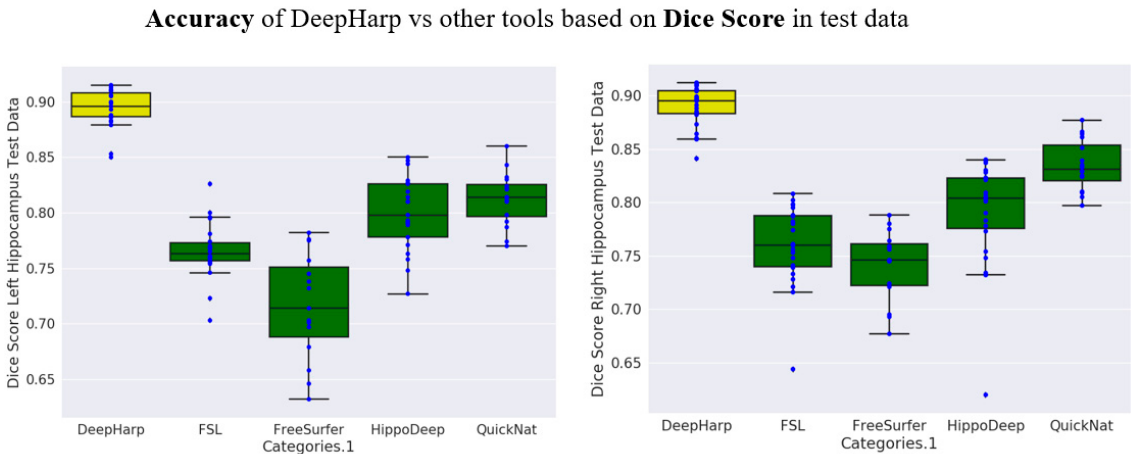
Table 2. Accuracy and precision of the DeepHarp method compared to other methods: the metric is the Dice coefficient. The bold numbers are showing highest Dice scores. DeepHarp has highest Dice score in accuracy and HippoDeep has highest Dice score in robustness.